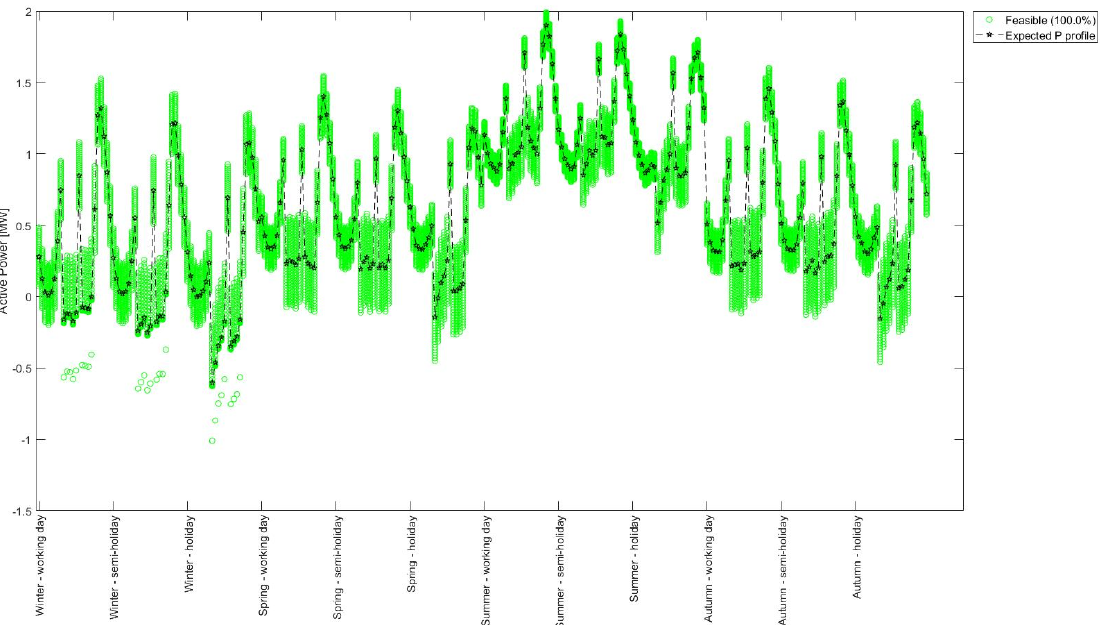
Figure 6. Potential P profile during all representative days, feeder U4—case A (“only